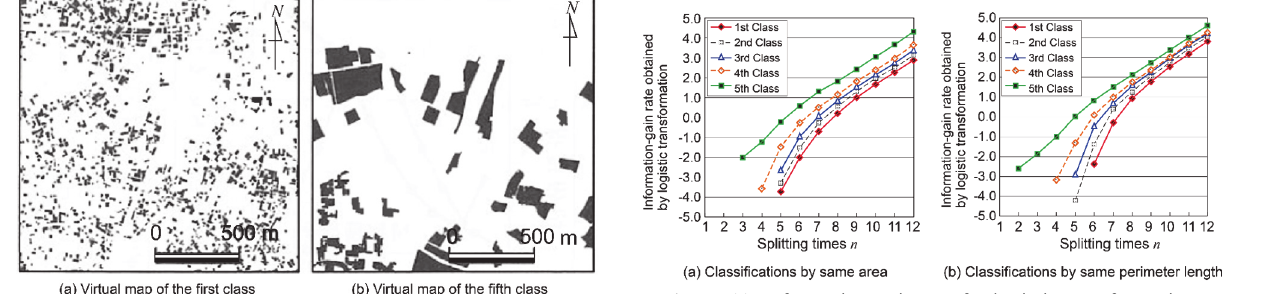
Figure 11 . Information-gain rate for logistic transformation.